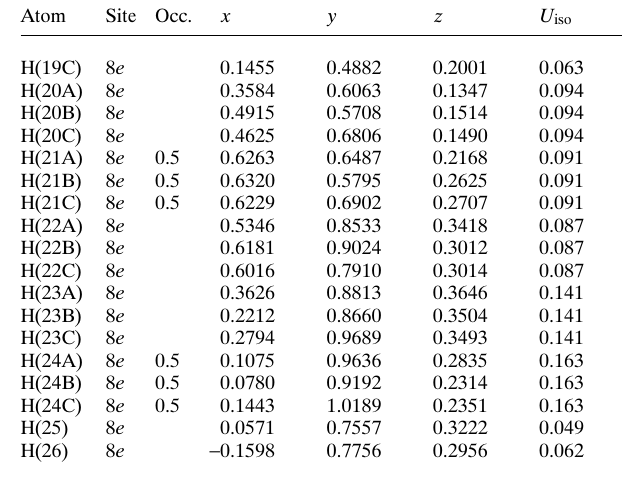
Table 2. Atomic coordinates and displacement parameters (in Å 2 ) . Atom Site